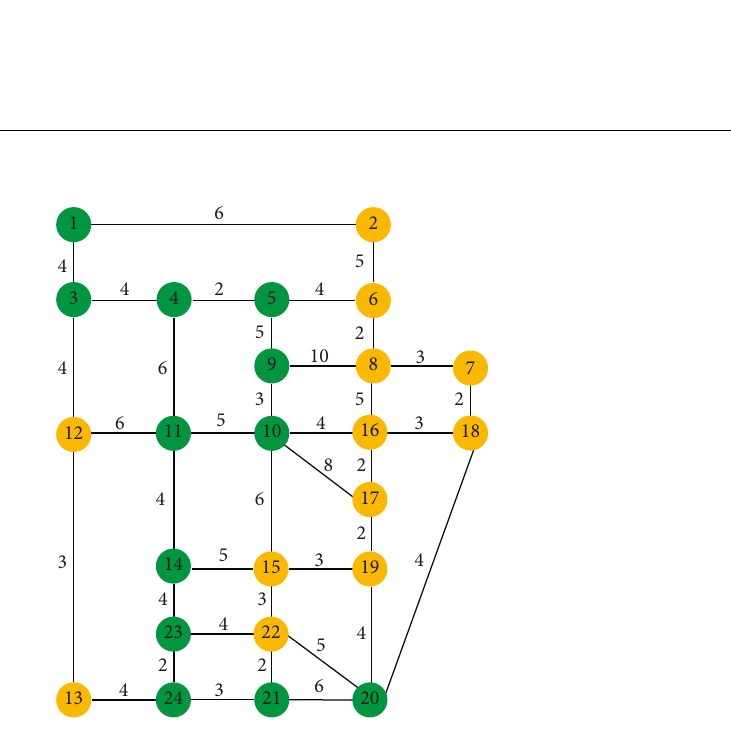
Figure 6: Simplified Sioux Falls